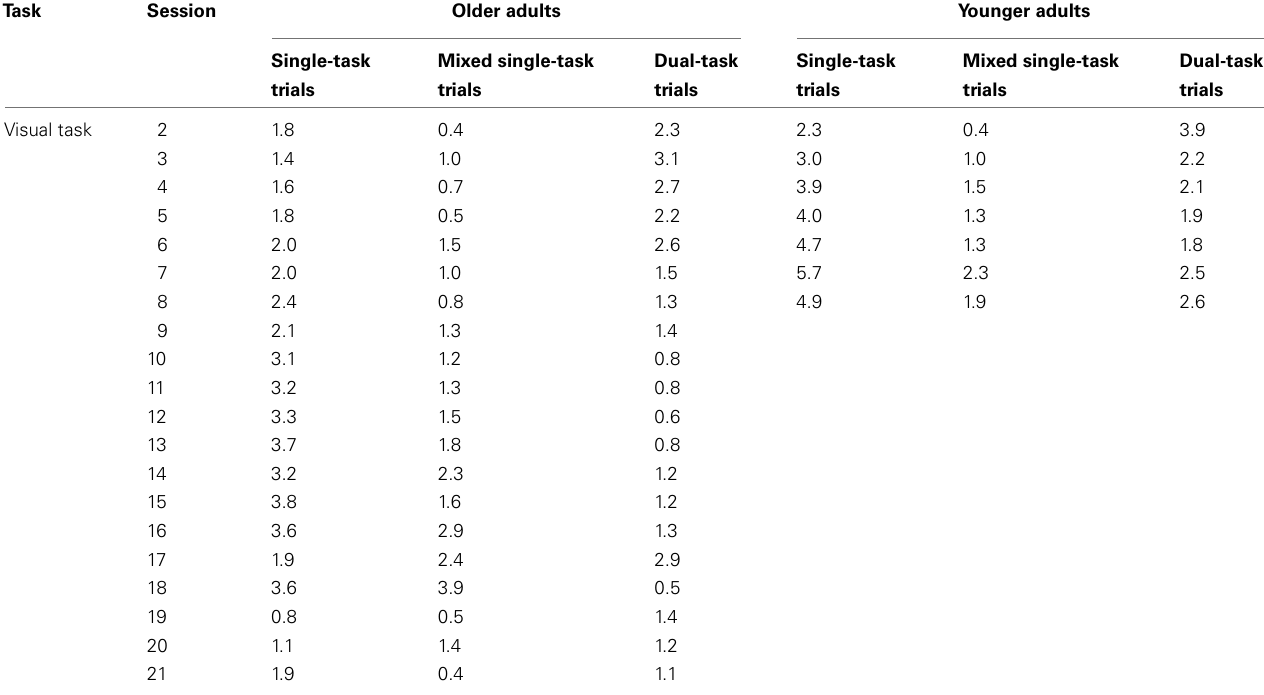
Table 1 | Error rates in percent in single-task trials of single-task blocks, single-task trials in mixed blocks (mixed single-task trials), and dual-task trials for the visual task in older and younger adults across Sessions 2–12 (older adults) or Sessions 2–8 (younger adults). Task Session Older adults Younger adults Single-task Mixed single-task Dual-task Single-task Mixed single-task Dual-task trials trials trials trials trials trials Visual